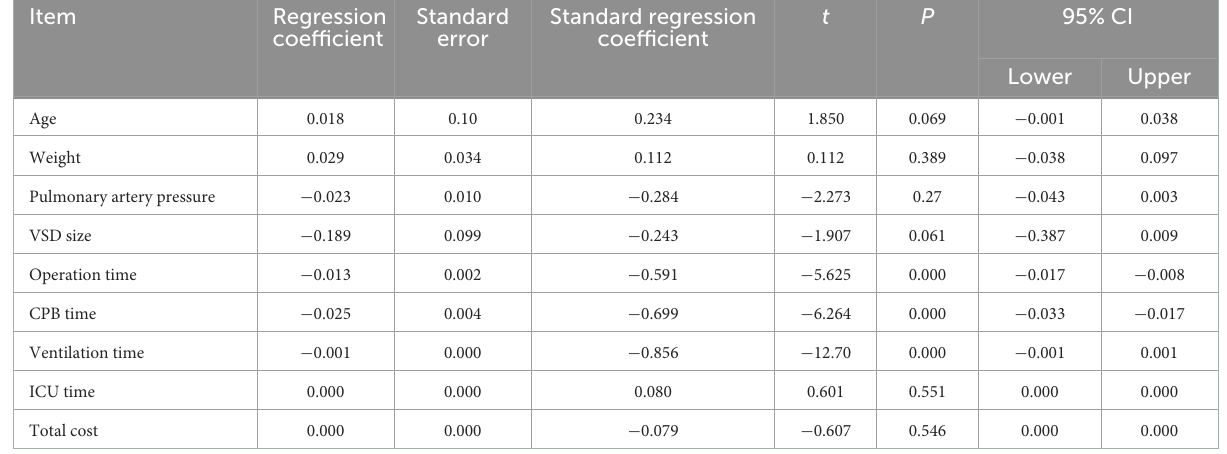
TABLE 4 Regression analysis of 6h serum lactate clearance rate in the matched surgical repair (S group). Item